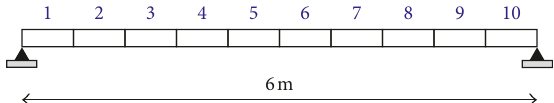
Figure 1: The beam structure under